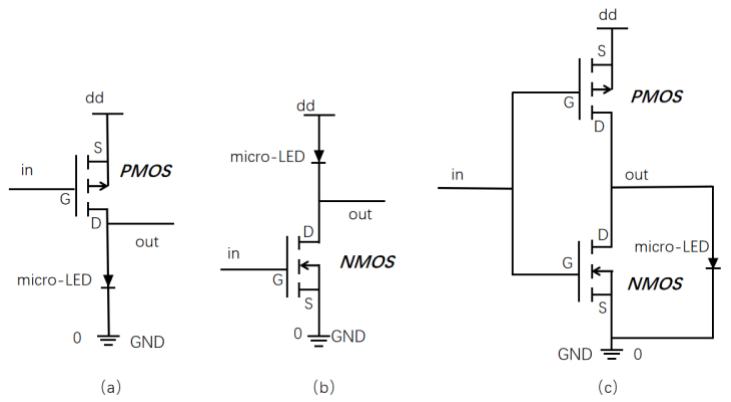
Figure 9. ( a )PMOS direct drive Micro-LED circuit diagram; ( b ) Circuit diagram of NMOS direct drive Micro-LED; ( c ) Circuit diagram of CMOS inverter directly driving Micro-LED.